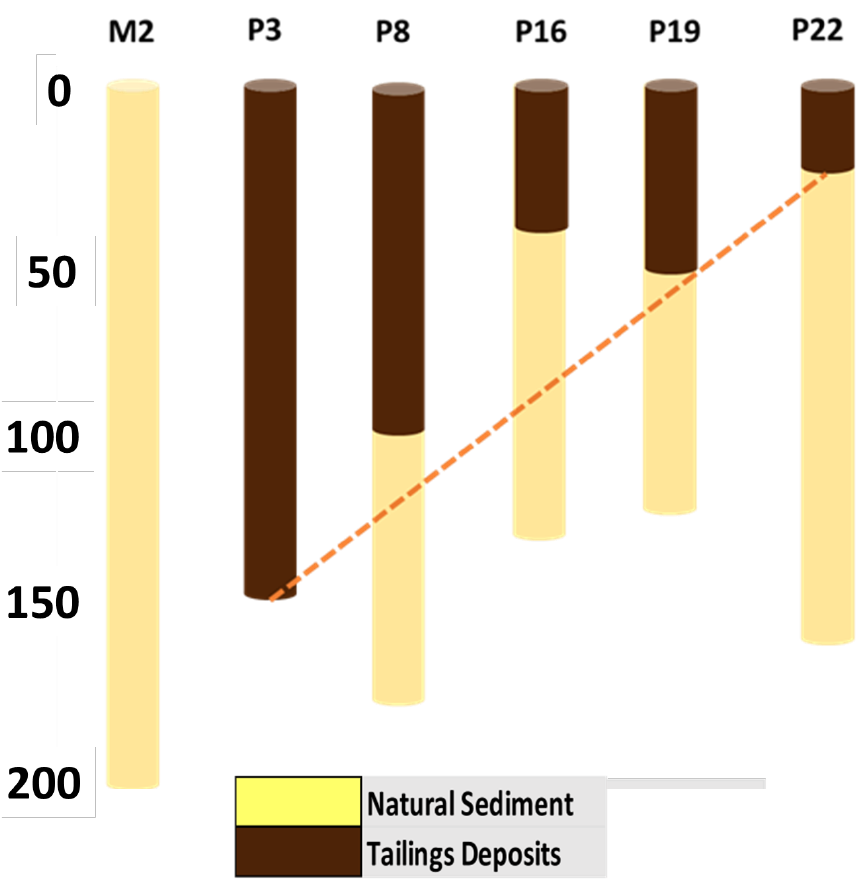
Figure 14. Vertical distribution (cm) of sediments and tailings along the Paraopeba River.